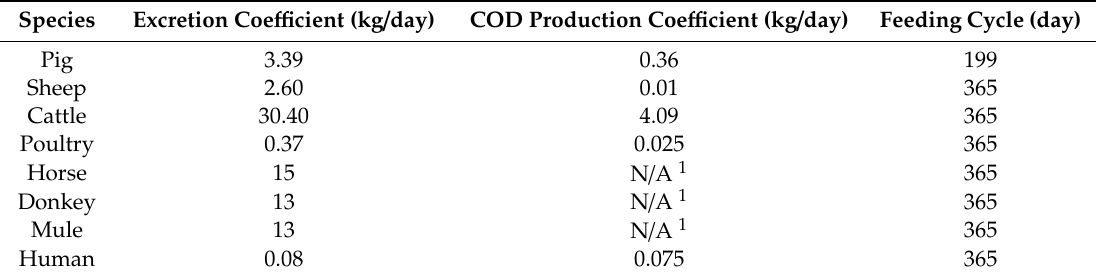
Table 5. Excretion coe ffi cient, COD production coe ffi cient, and feeding cycle in 2016 [75,77,80,81]. Species